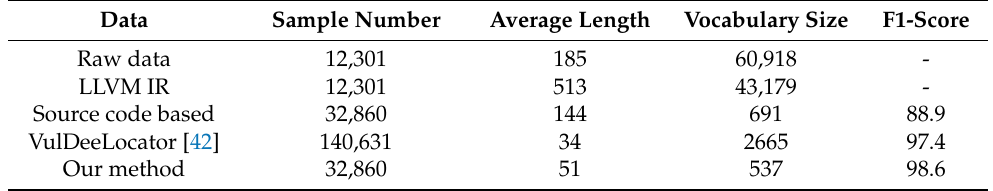
Table 2. Results for RQ1. Evaluating the performance of different intermediate